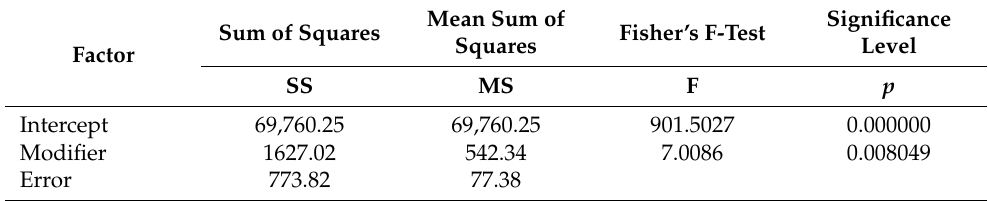
Table 5. Statistical evaluation (ANOVA) of the influence kind of implementation on the growth of Chaetomium globosum on the bacterial cellulose surface. Mean Sum of Significance Sum of Squares Fisher’s F-Test Squares Factor